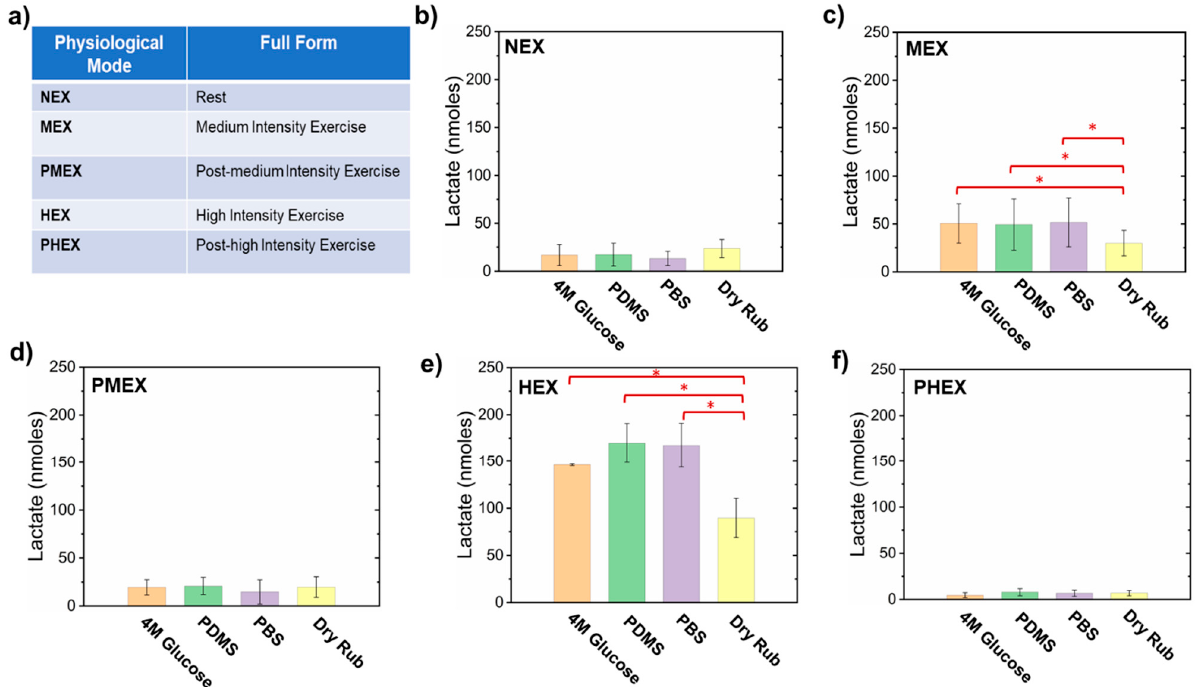
Figure 2. Plots presenting a comparative analysis of the sampled average sweat lactate quantity with different pumping materials in the patch under varying physiological conditions. ( a ) Table highlighting the full forms of all the physiological conditions in which the human subjects were tested. Plot showing the amount of lactate sampled during ( b ) NEX trial, ( c ) MEX trial, ( d ) PMEX trial, ( e ) HEX trial, and ( f ) PHEX trial. These plots show that all pumping materials in the patch can sample lactate on paper. Error bars denote the standard deviation obtained from all subjects. * p < 0.05.